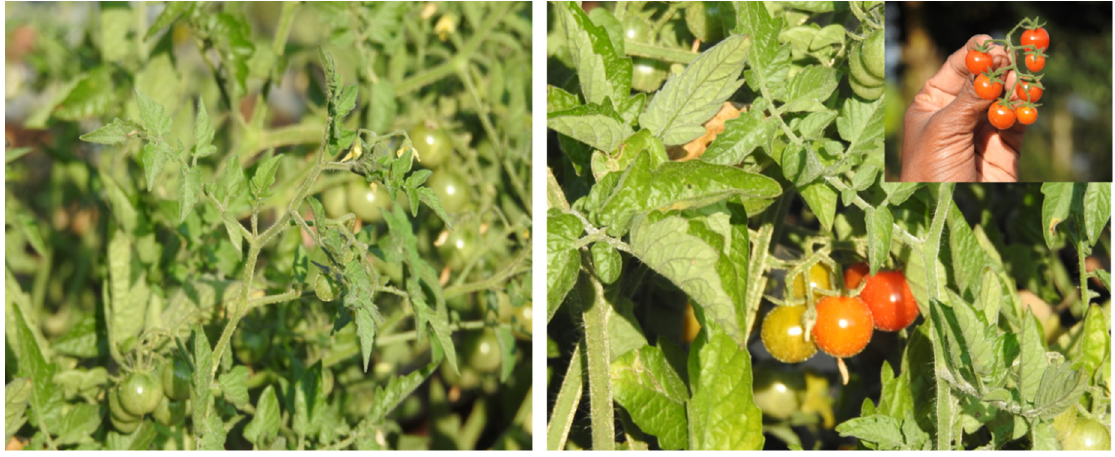
Figure 4. Cherry tomato plants.